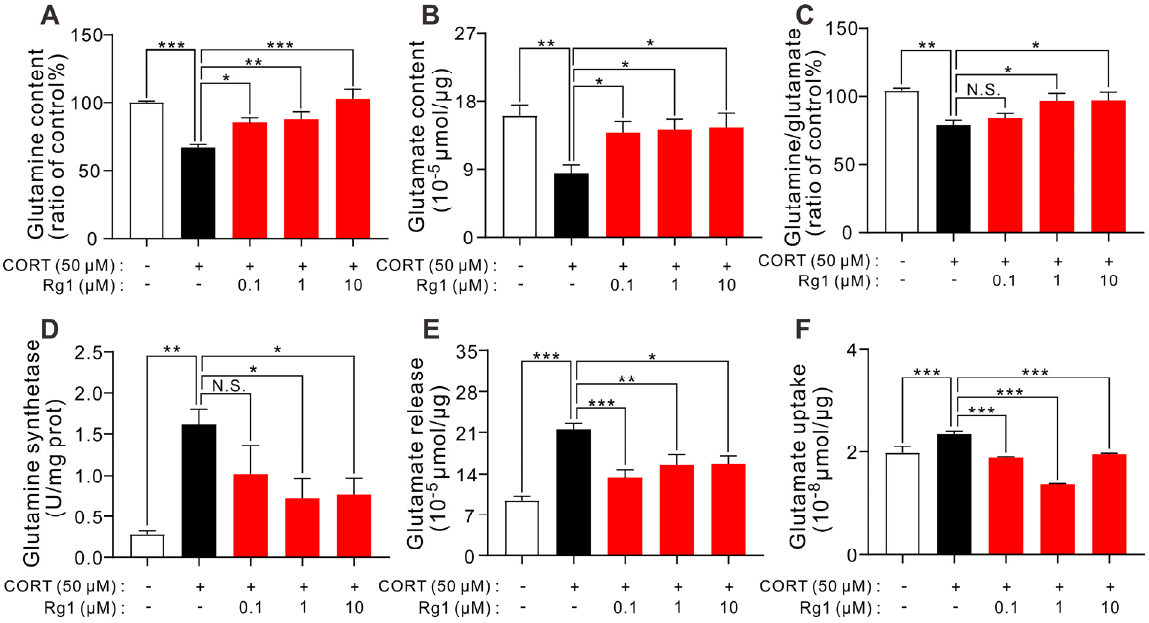
Figure 5. Rg1 ameliorated dysfunction in astrocytes induced by CORT. ( A – C ) CORT incubation significantly reduced total glutamine content ( A ), glutamate content ( B ), and the ratio of glutamine to glutamate ( C ) in astrocytes, and Rg1 pretreatment (1 and 10 µM) reversed all of these decreases. ( D ) Rg1 pretreatment (1 and 10 µM) reversed the increase of glutamine synthetase activities induced by CORT. ( E ) CORT incubation significantly increased glutamate release in astrocytes, and the increase was reversed by Rg1 (0.1, 1, and 10 µM) pretreatment. ( F ) The increased glutamate uptake induced by CORT was decreased by Rg1 pretreatment of all three concentrations (0.1, 1, and 10 µM). All data are shown as mean ± SEM ( n = 6 ). * p < 0.05; ** p < 0.01; *** p < 0.001. CORT, corticosterone; GS, glutamine synthetase; N.S., no significant differences.